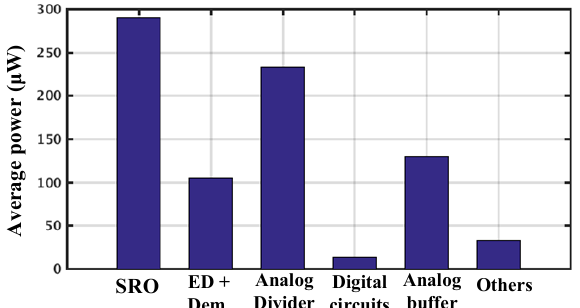
Figure 23. The simulated power consumption